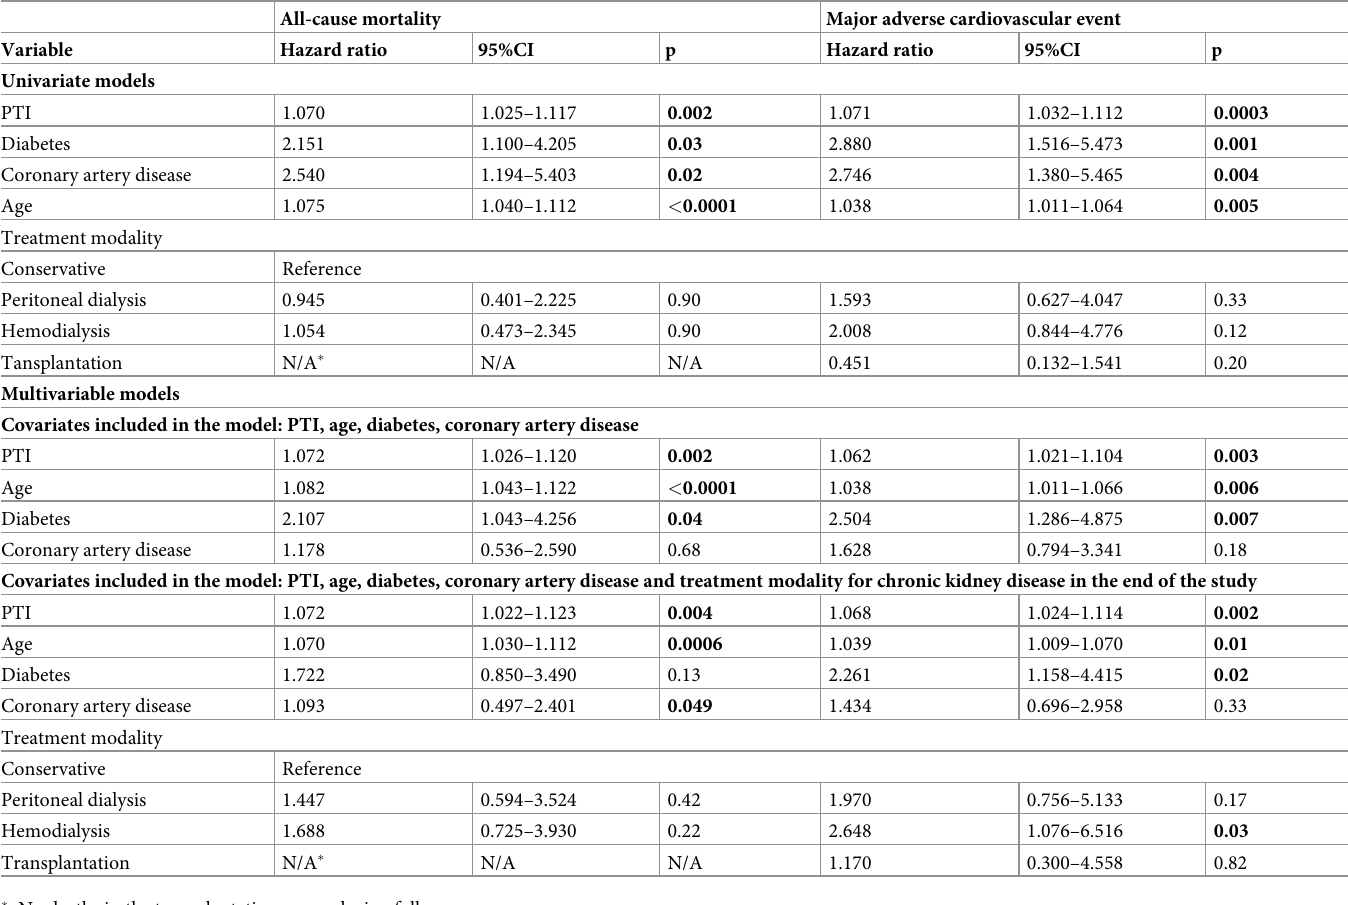
Table 3. Univariate and multivariable